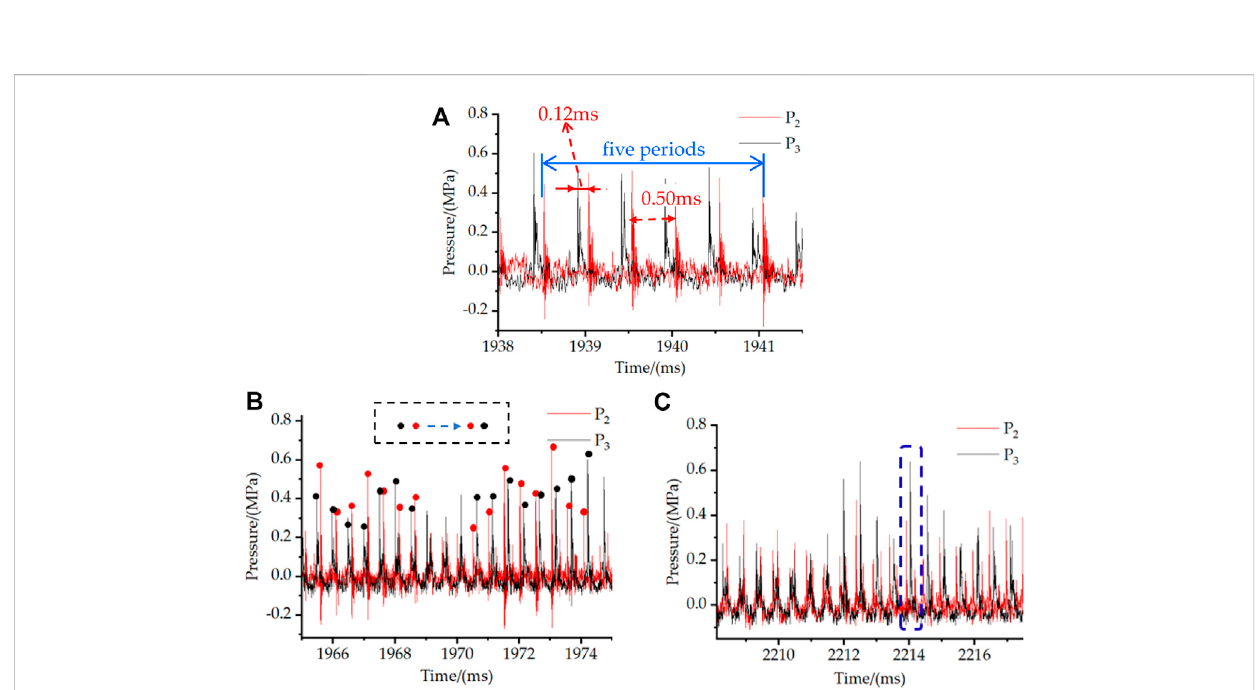
FIGURE 5 Different modes of the propagation: (A) Propagation of the single wave. (B) Reversion of waves. (C) Collision of double